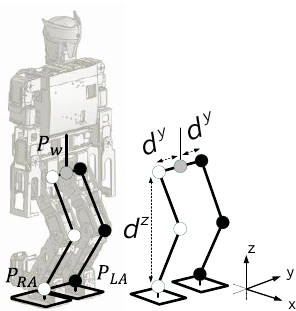
Figure 3. Diagram of the legs of TKU-X and its coordinate system.